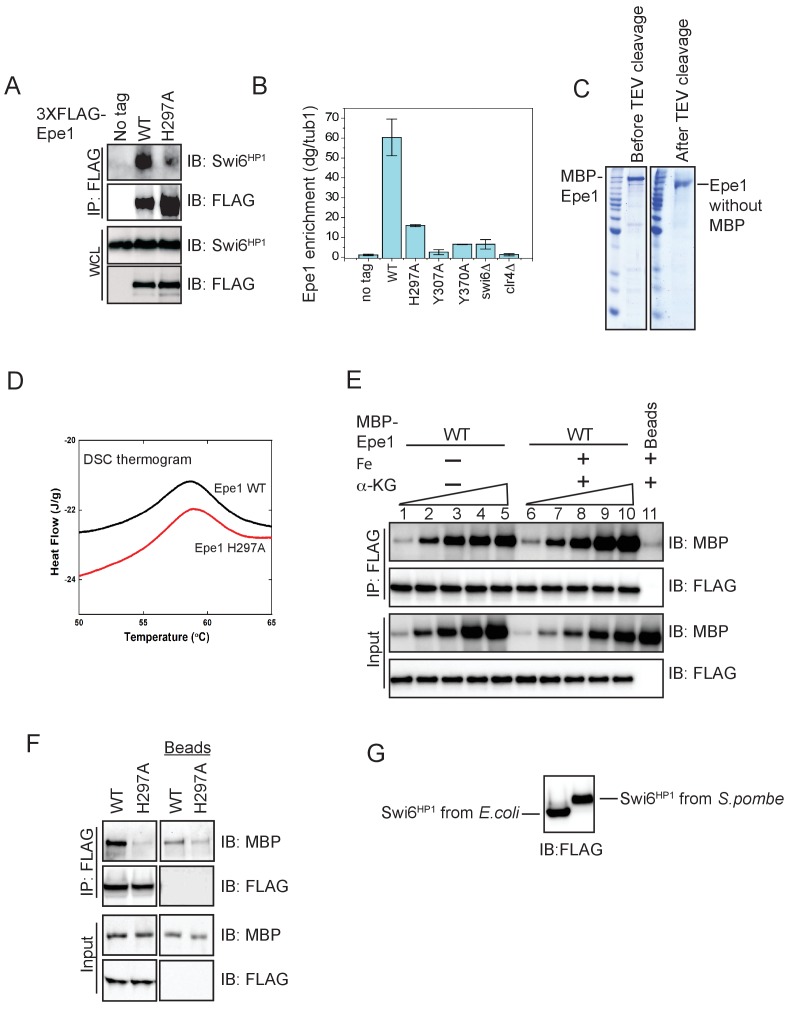
Characterization of recombinant Epe1 wild-type and Epe1 mutant proteins.(A) Western blot of a co-immunoprecipitation experiment in cells expressing Epe1 that is fused to a FLAG epitope tag at the N-terminus. N-terminal FLAG fusions of Epe1 and Epe1 H297A exhibit the same pattern of interaction with Swi6HP1 (the wild-type protein exhibits an interaction and the Epe1 mutant exhibits reduced binding) as their C-terminal counterparts. (B) ChIP-qPCR measurements of Epe1 occupancy at the pericentromeric dg repeats. The use of additional crosslinkers improves crosslinking efficiency and traps transient interactions. The wild-type Epe1 protein is enriched at sites of heterochromatin formation, whereas Epe1 JmjC mutants do not exhibit any significant enrichment. (C) Recombinant Epe1 protein purification from insect cells before and after cleavage of the MBP tag. Epe1 purified from Sf9 insect cells remains soluble even after MBP tag cleavage. (D) Differential scanning calorimetry (DSC) assays demonstrate that wild-type Epe1 and Epe1 H297A proteins exhibit similar denaturation temperatures, implying that the proteins are equally stable in vitro. The difference in peak intensities reflects slightly different protein amounts in the DSC. (E) In vitro binding assays between Epe1 and Swi6HP1 in the presence of Fe (II) and α-ketoglutarate as co-factors. The presence of Fe (II) and α-ketoglutarate did not alter the binding between Epe1 and Swi6HP1 compared to reactions performed in the absence of any co-factors. (F) In vitro binding experiments using recombinant wild-type and Epe1 H297A proteins with Swi6HP1 purified from fission yeast cells. 3X FLAG- Swi6HP1 was expressed at endogenous levels in fission yeast and purified under high salt conditions. The fission yeast Swi6HP1 protein exhibits the same binding preference for wild-type Epe1 as E. coli Swi6HP1. (G) Swi6HP1 purified from S. pombe exhibits a mass shift compared to Swi6HP1 purified from E. coli because of protein phosphorylation. Therefore, our purification approach preserves the endogenously phosphorylated state of Swi6HP1.